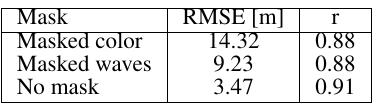
Table 2. Performance comparison of the H-DSPEB architecture after masking parts of the inputs.